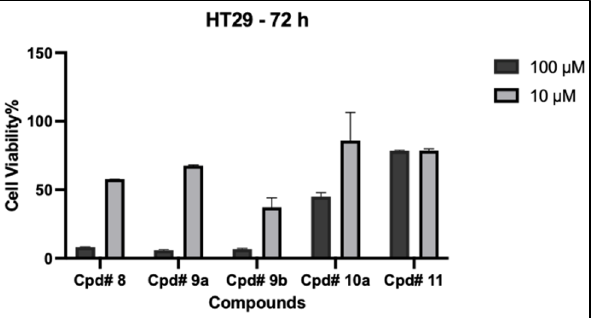
Figure 3. Top screening scoring synthesized compounds on the viability of HT-29. Cells were treated with 10 and 100 μ M for 72 h and cell viability was determined using MTT assay. Data are expressed as mean ± SD; n = 3.